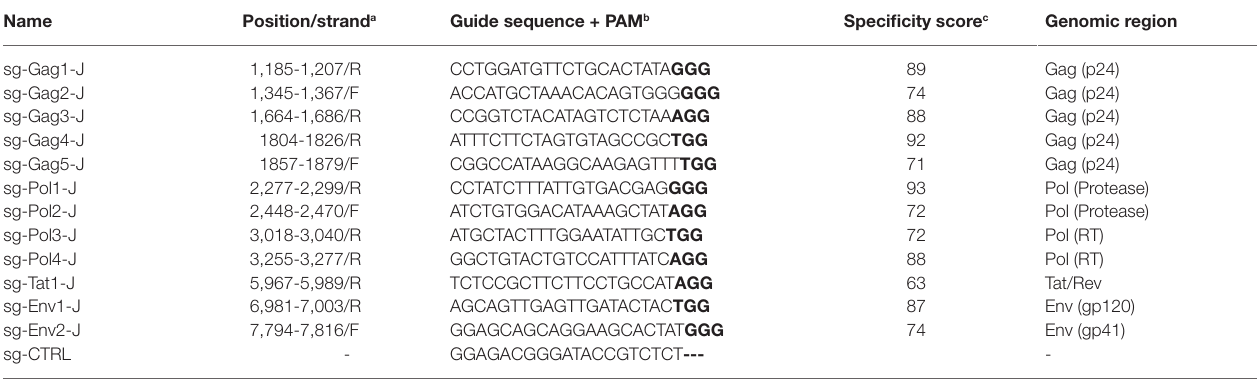
TABLE 1 | Selected sgRNAs targeting HIV-1